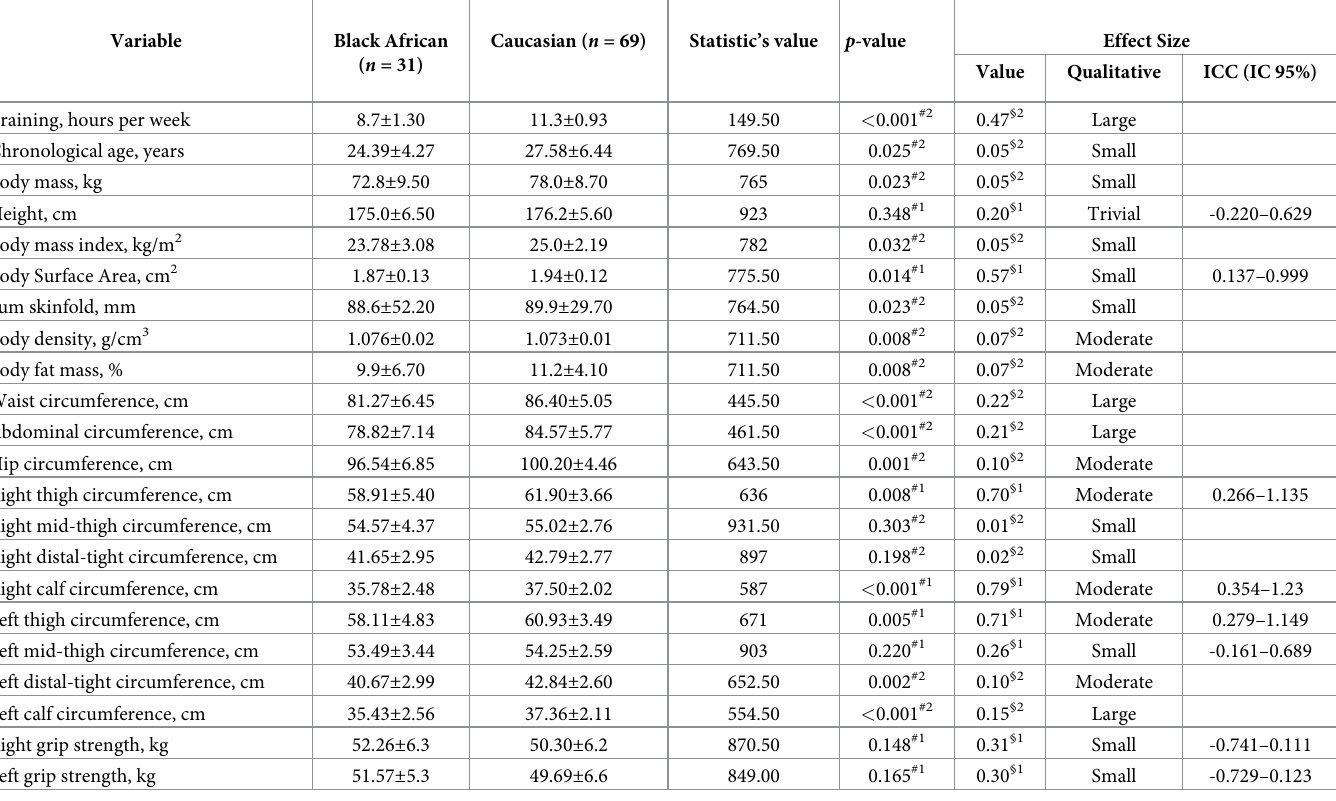
The results of Table 1 display the body composition traits and grip strength references of rink hockey athletes with a regular weekly training volume of 10.50 ± 1.55 hours. BM showed an average of 76.36 ± 9.18 kg, and an average of 175.8 ± 5.87 cm was assessed for height. BMI reveals a high limit for normal weight (24.68 ± 2.56 kg/m2). The summary of the 9 skinfolds (89.49 ± 37.88 cm) reflects a BF% of 10.82 ± 5.07%. The BSA is set at 1.92 ± 0.12 m 2 . Hand grip strength was tested, with 88% of the sample referenced as right-hand dominant and 12% left- hand dominant. For maximal RGST it was obtained at 50.91 ± 6.26 kg and 50.27 ± 6.23 kg for LGST. Table 2 summarized the comparison between ethnicity group results. There were signifi- cant differences in several variables between players’ ethnicities. Caucasian athletes revealed significantly higher BM (77.97 ± 8.65 kg) than Black athletes (72.78 ± 9.47 kg). There were also significant differences in BMI and BSA between groups, 23.78 ± 3.08 kg/m 2 and 1.87 ± 0.13 m 2 for Black athletes, while 25.0 ± 2.19 kg/m 2 and 1.94 ± 0.12 m 2 for Caucasians athletes. Body density is significantly higher for Black athletes (1.076 ± 0.015) than for Caucasians (1.073 ± 0.009). Regarding the BF%, significantly higher results were observed for Caucasian rink hockey athletes (11.21 ± 4.13) than for Black athletes (9.94 ± 6.72). In regards to the circumference measurements, elite male Black rink hockey athletes had significantly lower values than Caucasian athletes in almost all variables, respectively; WC Table 2. Descriptive statistics (mean ± standard deviation) by group and mean differences in anthropometry and strength variables. Variable Black African Caucasian ( n = 69) ( n = 31)